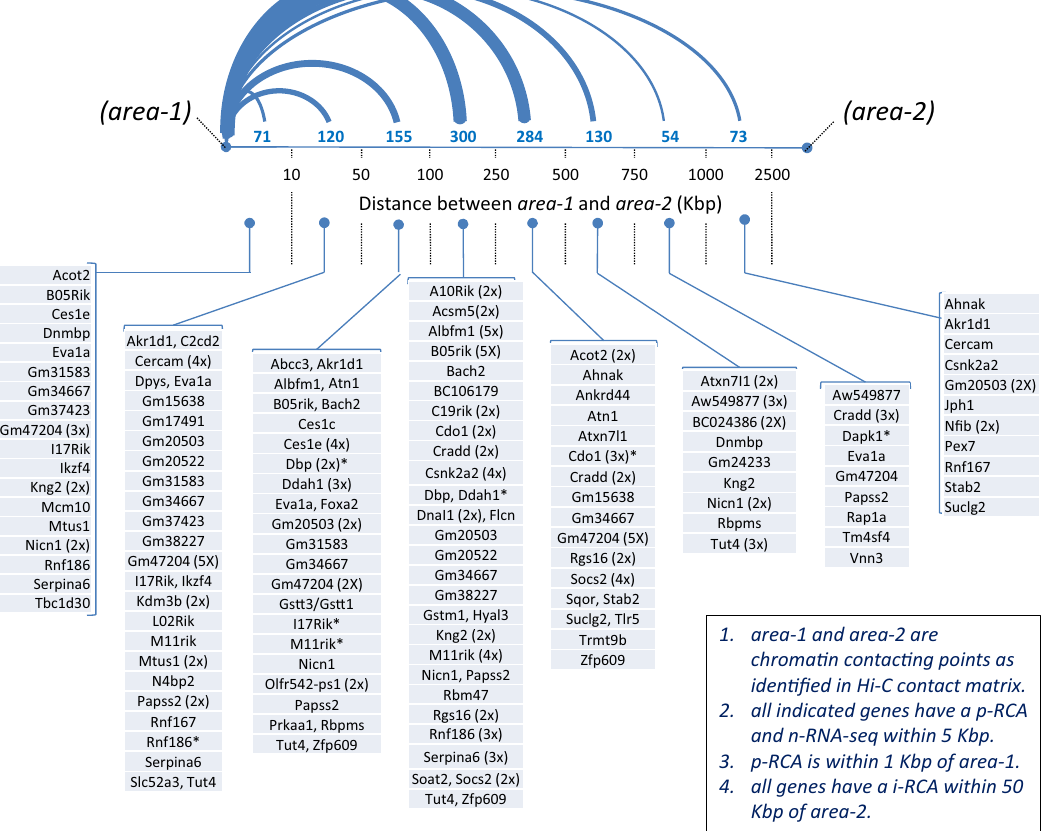
Fig. 5 Distribution of Hi-C interacting points ( area-1 and area-2 ) located nearby p-RCA areas ( area-1 ) and i-RCA areas ( area-2 ). Only area-1 within 1 Kbp of a p-RCA are shown; the number of area-2 contacting points at each distance bracket is indicated in green and by the relative thickness of the connecting lines; the 120 gene names shown re fl ect those genes that satisfy the following criteria: a having a n-RNA-seq peak within 5 Kbp of a p-RCA; b having a p-RCA area within 1 Kbp of an area-1 ; c having an i-RCA area within 50 Kbp of an area-2 ; in parenthesis after each gene name is the number of interacting areas-2 ; Asterisk indicates the presence of a H-site within 50 Kbp of area 2 . Note that the following genes that were originally included among the 146 are not shown here because they did not meet the strict criterion of having a p-RCA within 1000 bp of a Hi-C area-1 :Ncor-1, Rmf167, Cdk5R1, Afmid, Sav1, Zbtb1, Ighm, Gm49413, M09Rik, Sco2, Tymp, Odf3b, Dnmdp, Echdc3, Gstm6, Adgrl2, Lurap1l, Gbp11, Smurf1, J07Rik, O19Rik, Pixbc1, Traip,